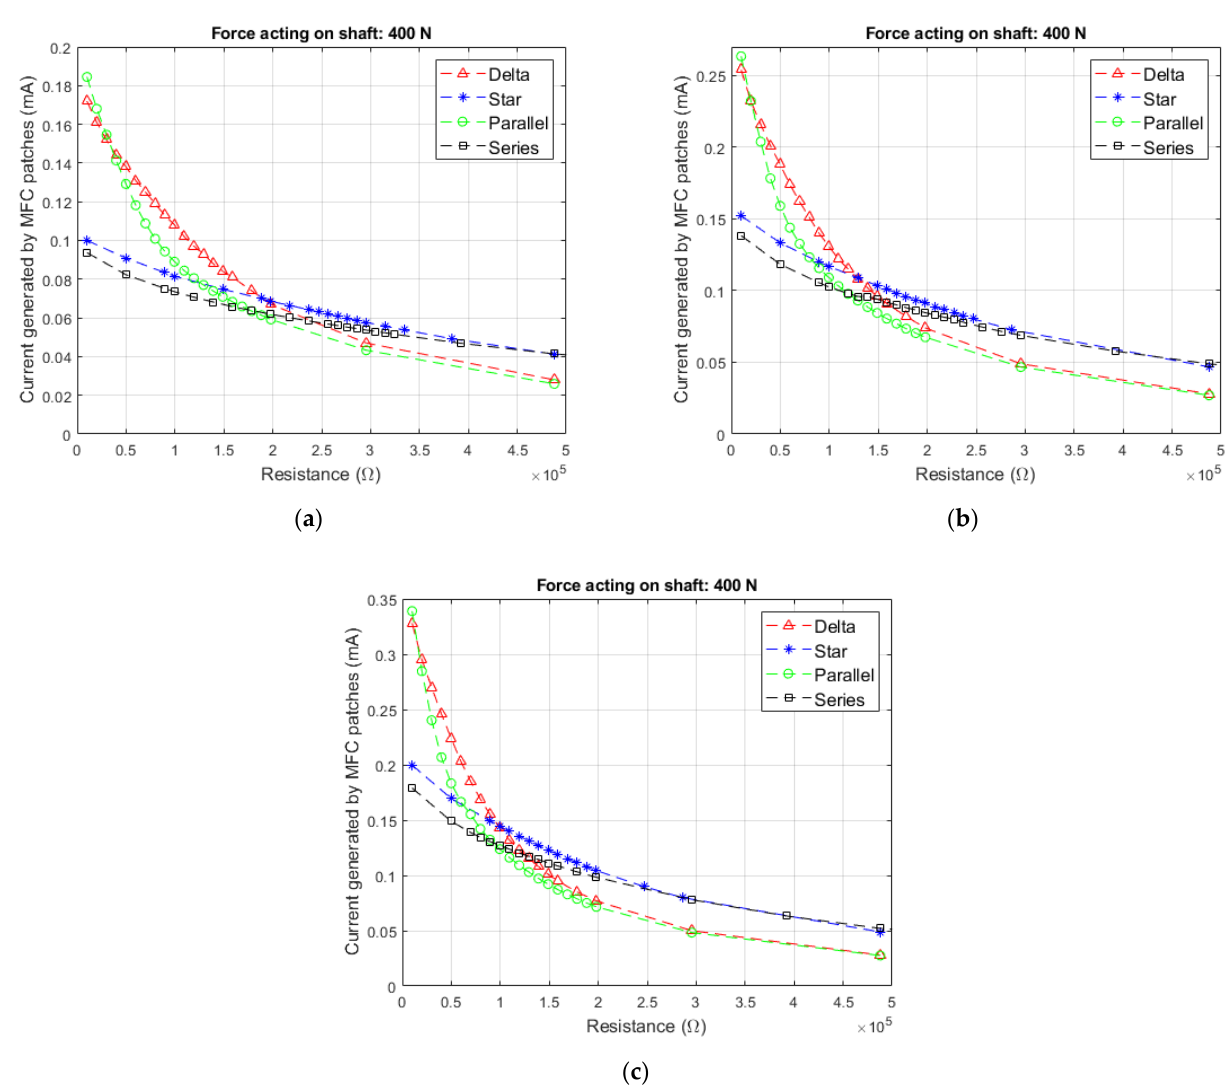
Figure 6. Electrical power generated for a force equal to 400 N: ( a ) rotational speed equal to 10 rps; ( b ) rotational speed equal to 15 rps; and ( c ) rotational speed equal to 20 rps.